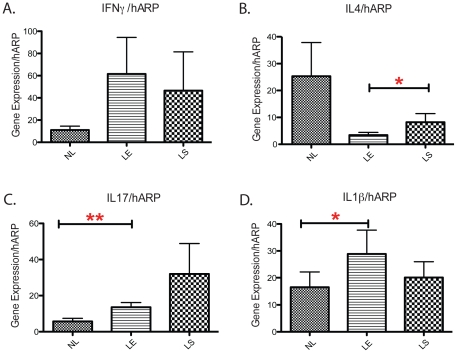
qPCR analysis of Th1, Th2 and Th17 cytokines in non-lesional, leading
edge and lesional skin.Gene expression levels of key cytokines were adjusted against hARP across
matching non-lesional, leading edge and lesional vitiligo skin pairs.
(A) IFN-g and (B) IL-4 are hallmark cytokines for Th1 and Th2
polarization, respectively. (C) IL-17A and (D) IL-1ß serve as
hallmark cytokines for Th17 polarization; Two way paired t-tests are
performed for each data of gene expression data between non-lesional
v.s. lesional, non-lesional v.s.
leading-edge vitiligo skin. *p<0.05; **,
p<0.01.